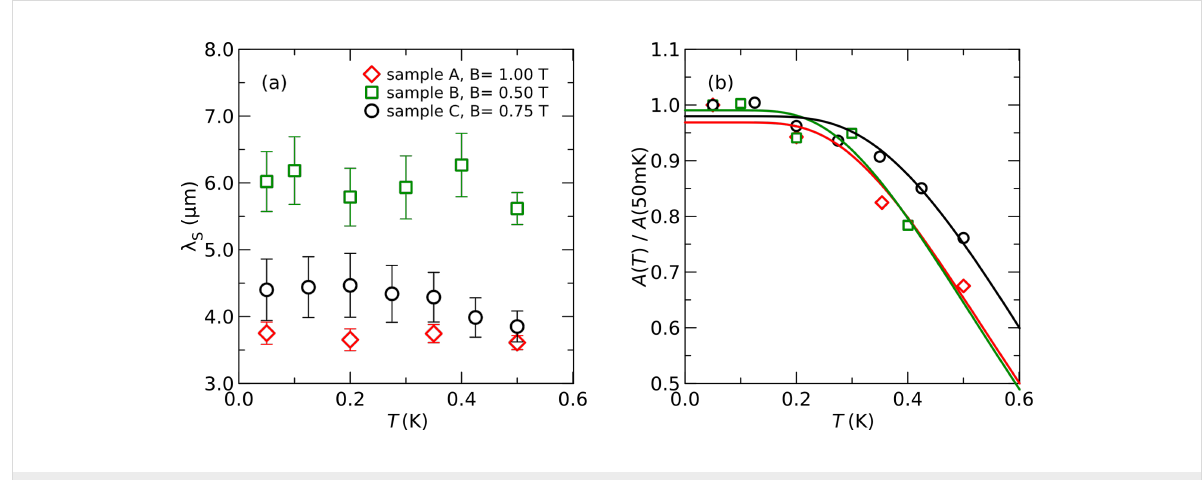
Figure 5: Spin relaxation length λ S (a) and amplitude A of the spin signal (b) for different samples as a function of the temperature T . Symbols are experimental data [17,18], lines are fits explained in the